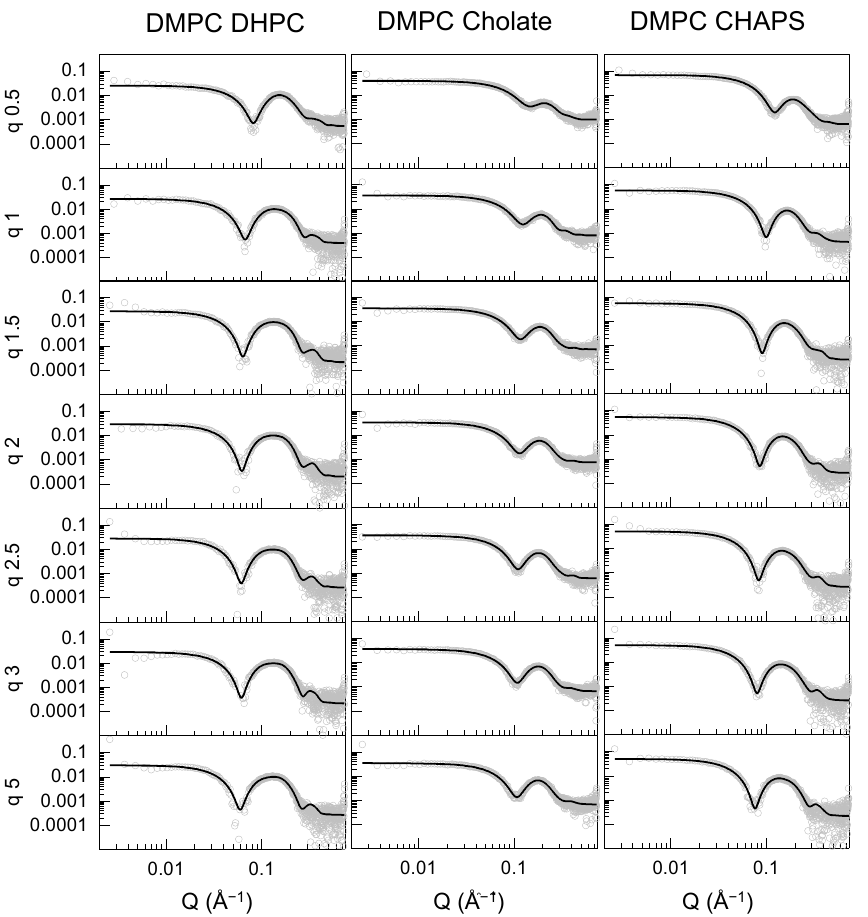
Figure 3. SAXS profiles (data points) and best fit to the bicelle model (lines) for DMPC particles composed of DHPC ( left ), cholate ( center ), and CHAPS ( right ) at seven different q ratios measured at 25 °C in TBS. Most of the SAXS data were measured in duplicate.